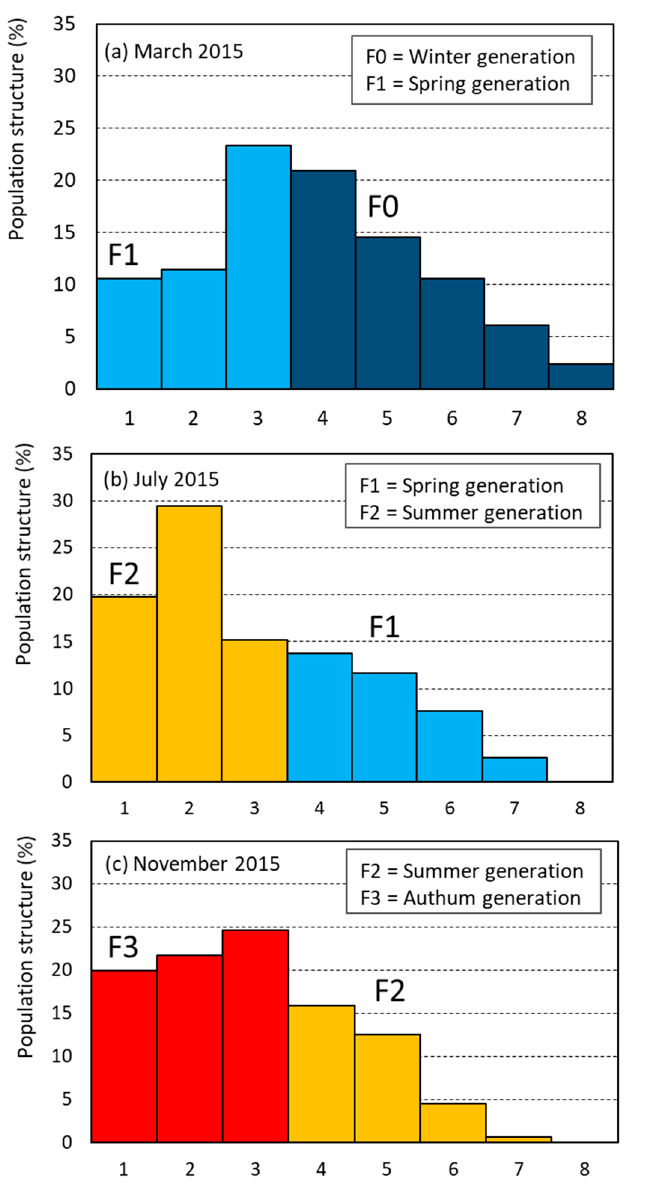
Figure 5. Population analysis of Asellus aquaticus in a drinking water network located in the European lowland in ( a ) March, ( b ) July and ( c ) November 2015. Shown are the abundance of water lice size classes from 1 to 8 mm; 1 and 2 mm represent embryonic stages, 3 mm represents the juvenile stage and >4 mm represents the adults (data of one drinking water network located in Northern Germany).